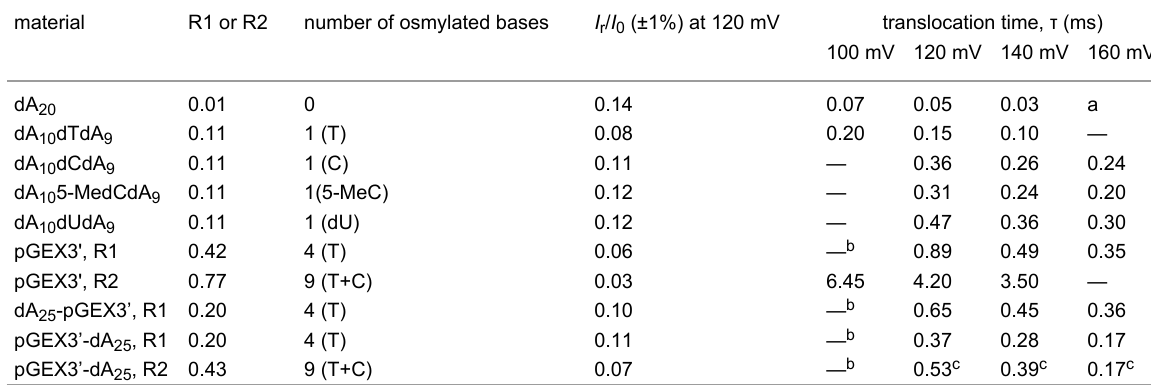
Table 2: List of Oligos used in this study together with the number of Ts and Cs osmylated bases. R1 or R2 (at 312 nm/272 nm) is given by the ratio of the peak area at the two different wavelengths following protocol A or protocol B, respectively. Sequence and purity of each oligo can be found in Table 1. Normalized current obstruction, I r / I 0 , ( trans vs cis ). Translocation time, t or τ , is obtained from the events-vs-time histogram. Experimental conditions: 10 μ M DNA in 1.0 M KCl, 10 mM PBS, pH 7.4, 22 ± 1 °C.